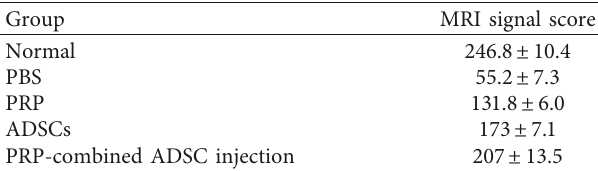
Figure 4: The injection of stem cells combined with platelet-rich plasma can significantly reverse the disc degeneration. The disc signals in magnetic resonance T2-weighted image in the group of ADSC-combined PRP showed higher signal strength than the other groups. Table 1: The signal intensity of the discs was evaluated by using T2- weighted images. All the MRI signal scores in five groups were detected by the software Image